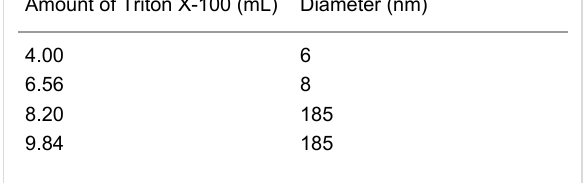
Table 1: Dimension of tin dioxide particles with varying amounts of surfactant. The amount of PEI was held constant. Amount of Triton X-100 (mL) Diameter (nm)